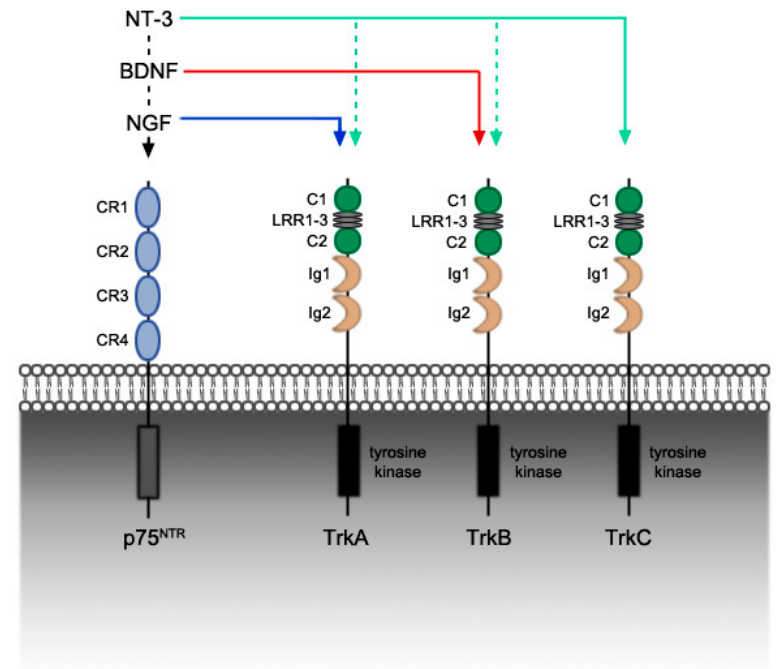
Figure 1. Neurotrophin binding to pan neurotrophin (p75 NTR ) and tropomyosin receptor kinase (Trk) receptors. All neurotrophins bind with low affinity to the p75 NTR receptor. Nerve growth factor (NGF) binds with high affinity to TrkA, and brain derived neurotrophic factor (BDNF) with high affinity to TrkB. Neurotrophin-3 (NT-3) binds with high affinity to TrkC, and may bind with low affinity to TrkA or TrkB depending on the cellular context. CR: cysteine-rich repeat, C: cysteine-rich cluster, LRR: leucine-rich repeat, Ig: Immunoglobin-like domain. Solid lines denote high affinity binding, dashed lines denote low affinity binding.